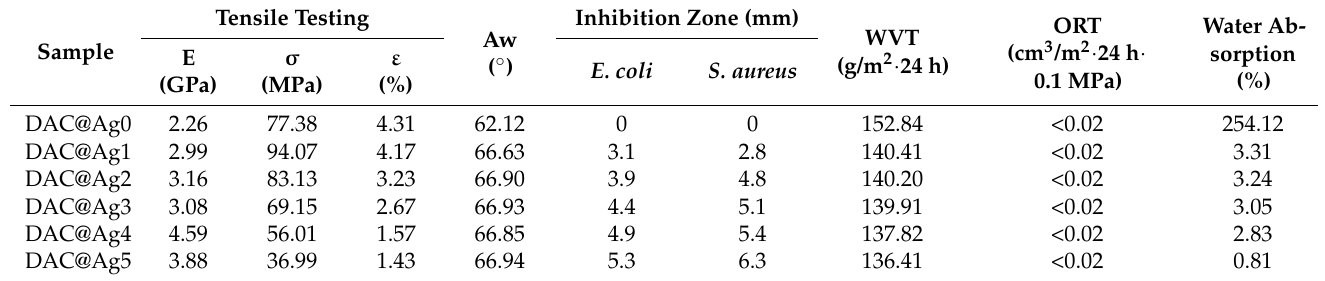
Table 1. Tensile testing, antimicrobial properties, barrier and water stability results for DAC@Ag films. Tensile Sample